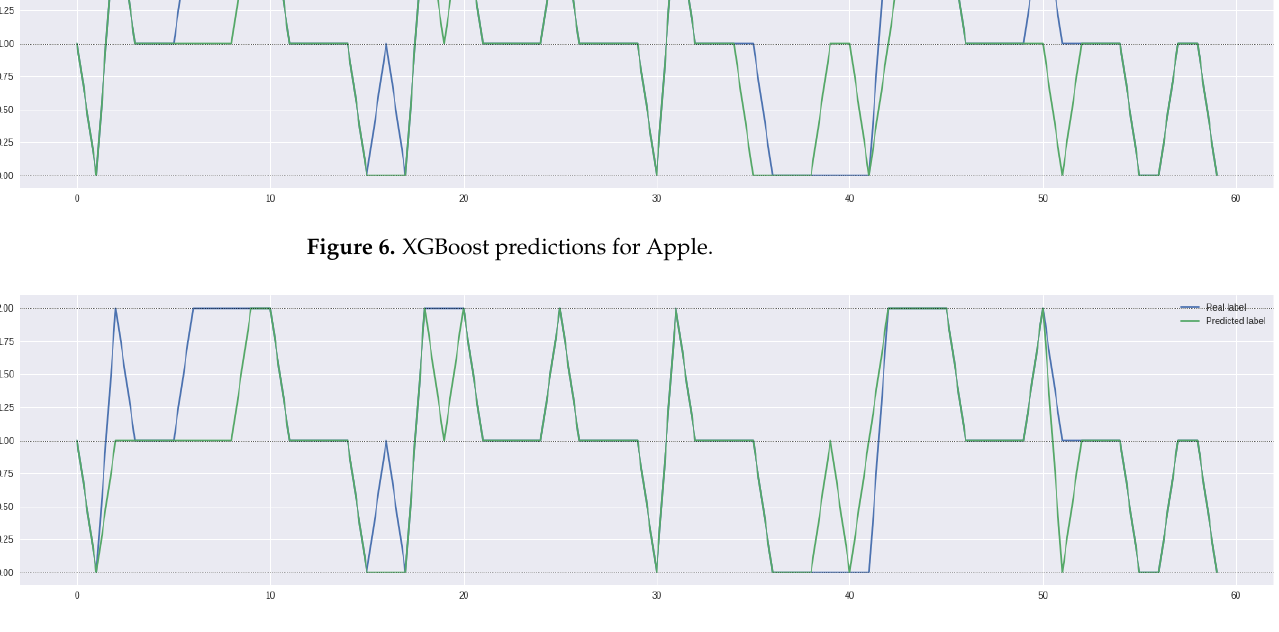
Figure 7. LGBM predictions for